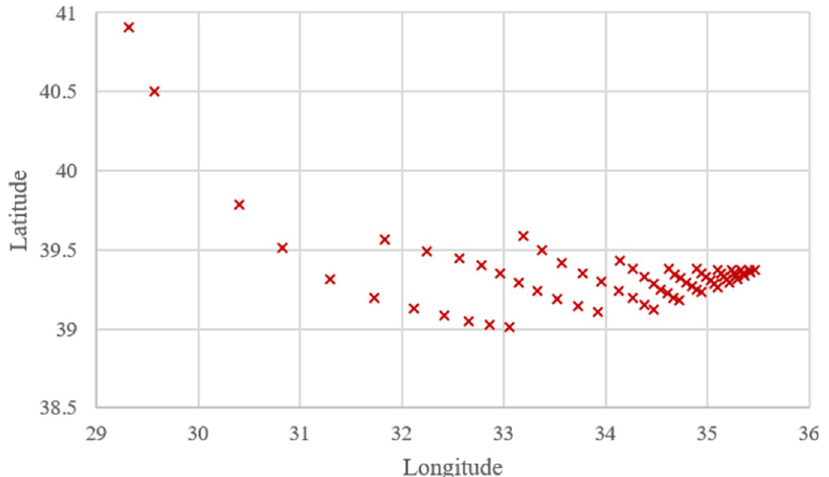
Fig 5. Optimum locations computed for 66 cases using